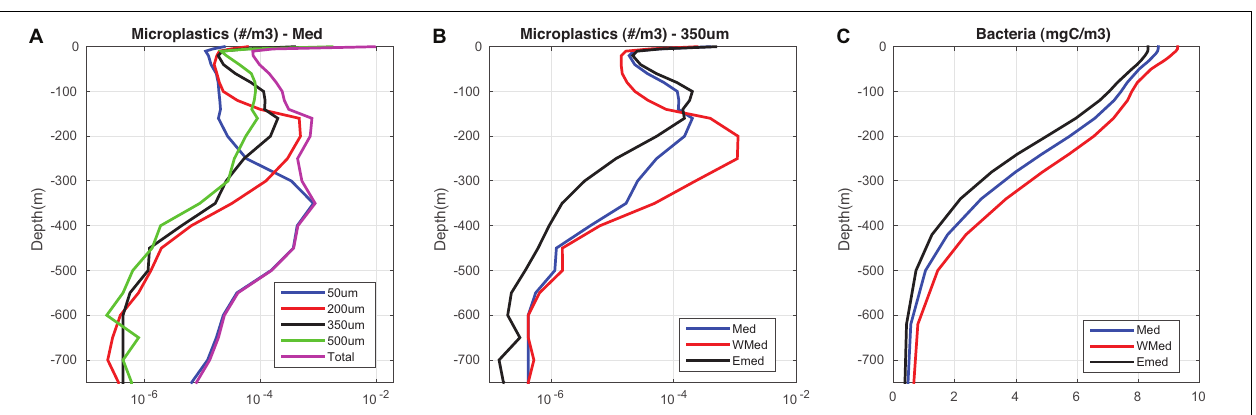
FIGURE 11 | Mean (2010–2017) model simulated vertical distribution in the water column of (A) microplastics concentration (#/m 3 ) (blue line = 50 µ m, red line = 200 µ m, black line = 350 µ m, green line = 500 µ m, magenta line = total), averaged (median) in the entire basin, (B) microplastics concentration (#/m 3 ) 350 µ m, averaged in the Eastern and Western Mediterranean and (C) simulated bacteria biomass vertical distribution averaged in the Eastern and Western